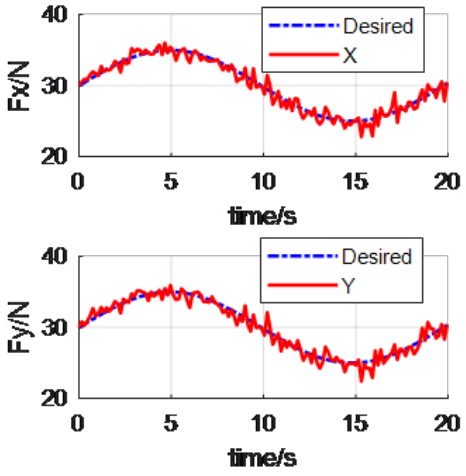
Figure 5. The tracking force via the RP force control.